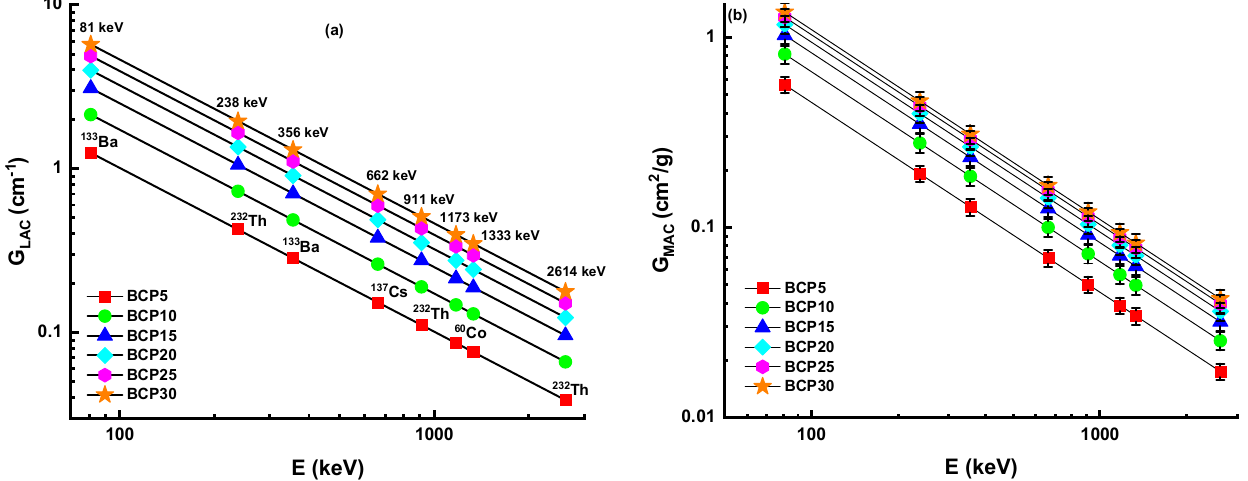
Figure 5. ( a ) Linear attenuation coefficient (G LAC ) and ( b ) mass attenuation coefficient (G MAC ) for glass samples.